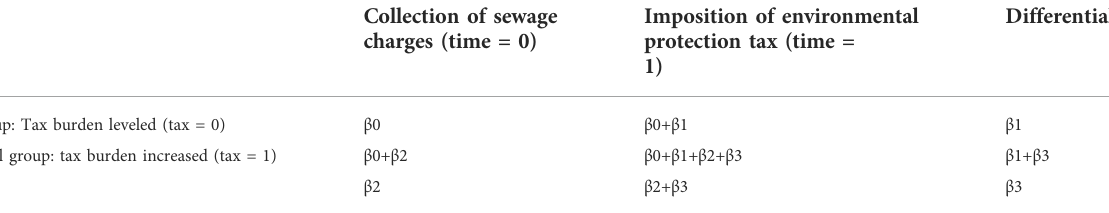
TABLE 3 Double-difference model and parameter de fi